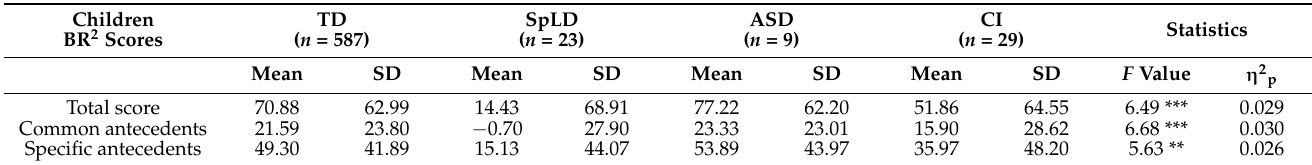
Table 2. Scores of parental risk and